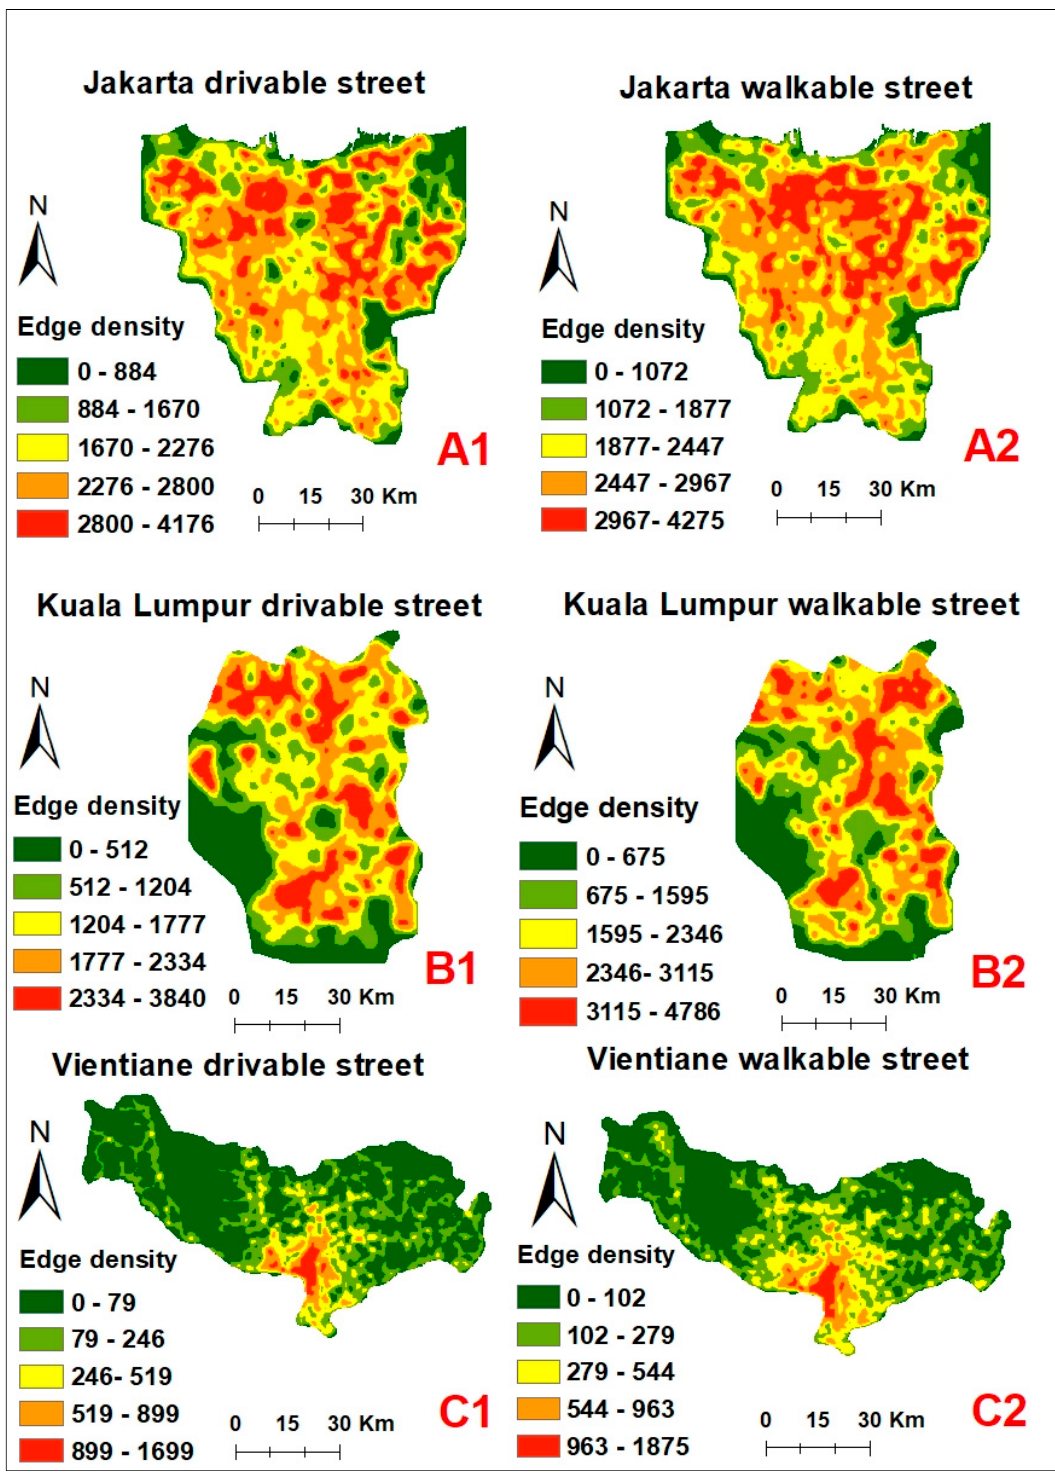
Figure 5. The spatial distribution of the edge density of driving and walking SNs of the metropolis ( A1 , A2 ), midsized city ( B1 , B2 ), and small city ( C1 , C2 ) using the kernel density estimation (KDE) in a default searching radius. The red colour represents the highest edge density for each SN type.